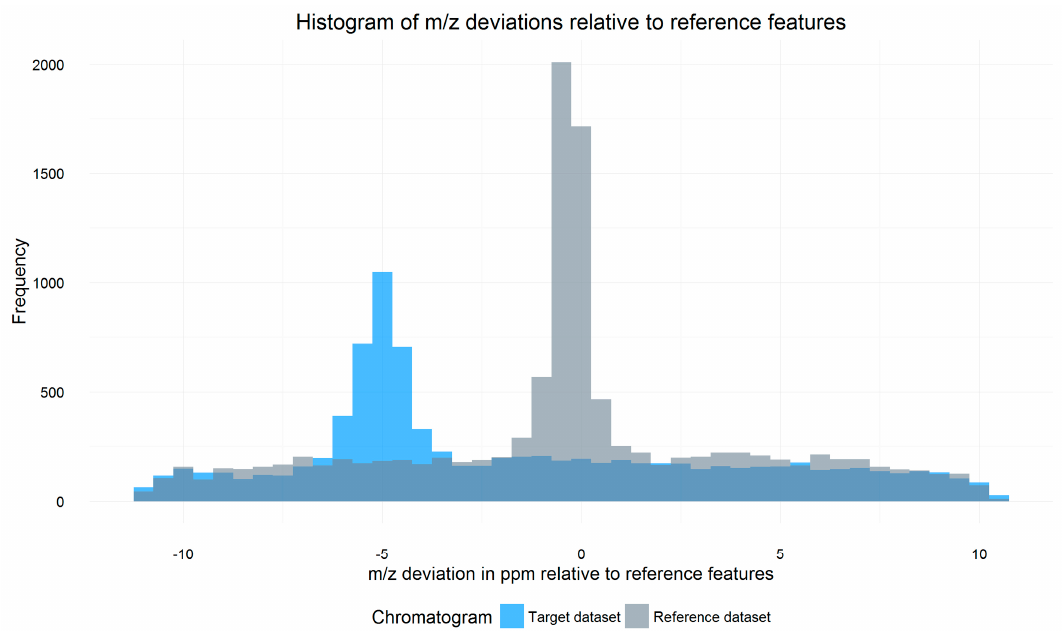
Figure 2. Overlay of two histograms showing the distribution of the weighted average mass to charge ratio ( m / z ) shifts of all search frames of a target file (blue) relative to a reference file (grey). The baseline frequency of about 200 is caused by unrelated signals, which have a random m / z shift relative to their respective reference feature. The m / z shift of signals corresponding to reference features is, however, not random and shows a significant increase around the systematic m / z offset of the respective file relative to the reference. This causes a maximum around the aforementioned offset. For the illustrated target datafile, this m / z offset was determined to be − 5 ppm.